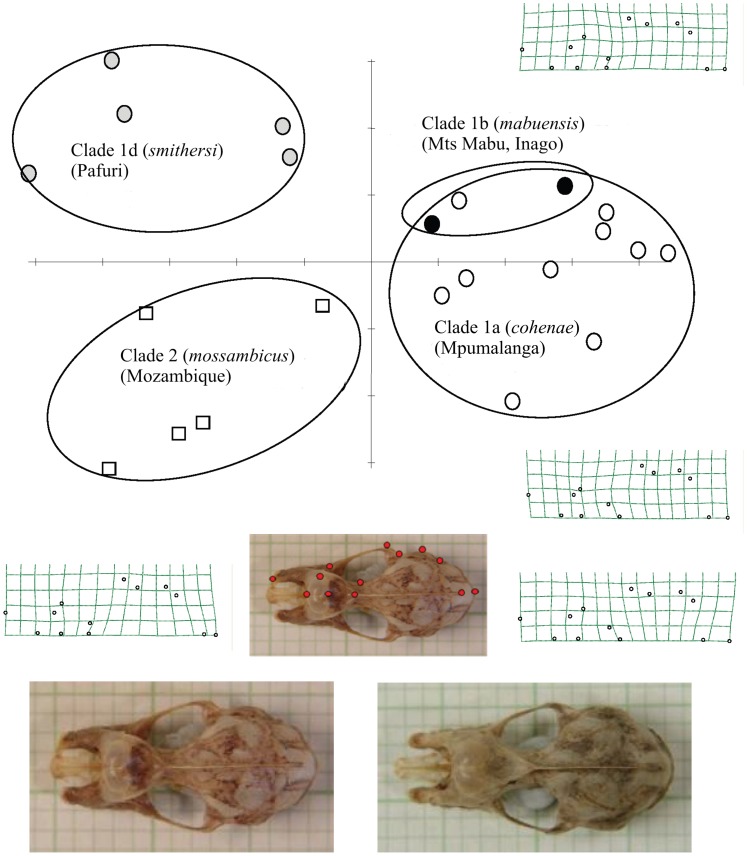
Relative warps analysis (RWA) of 13 dorsal cranial landmarks from 22 individuals of R. hildebrandtii s.l. belonging to two molecular clades and two lineages of Clade 1 (see
Fig. 3
).Revised taxon names are provided in parentheses (see Taxonomic Conclusions). Skulls which were included in this analysis are indicated in Table S1. Symbols as in Fig. 5. Thin plate splines (grids) show landmark distortions represented by extremes of variation on RW1 (left = negative; right = positive) and RW2 (bottom = negative; top = positive) axes. The two skull photographs at the bottom are of actual specimens representing the negative (left: TM 41997, smithersi from Pafuri) and positive (right: DM 11560, cohenae from Mayo, Mpumalanga Province) extremes of variation on RW1. Landmark positions (filled circles) are shown in the photograph in the centre.